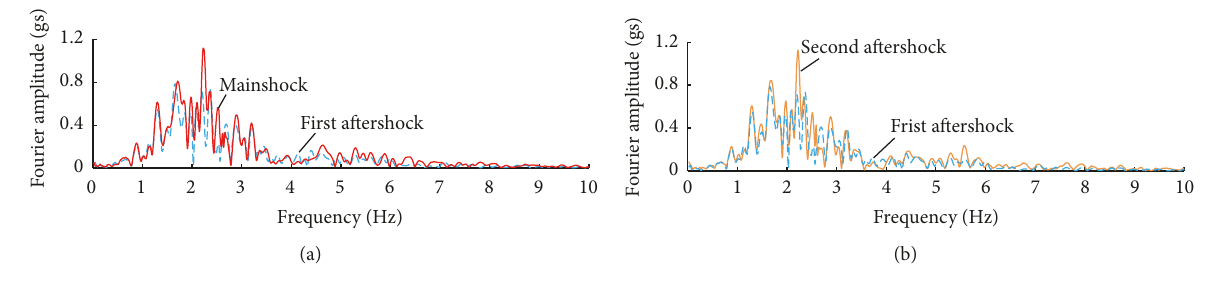
Figure 15: Frequencies content of structural top